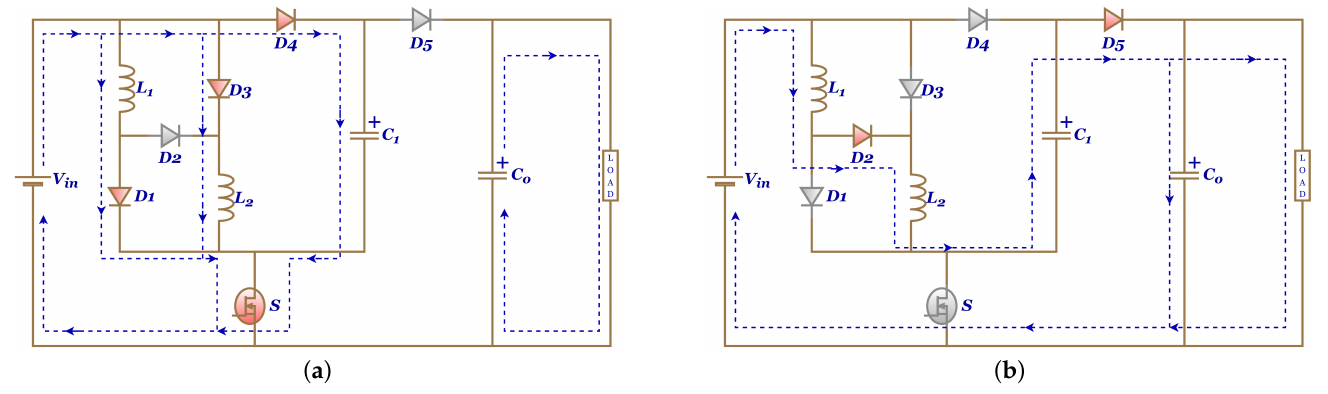
Figure 17. 1st M-PSOL operation: ( a ) S closed, and ( b ) S